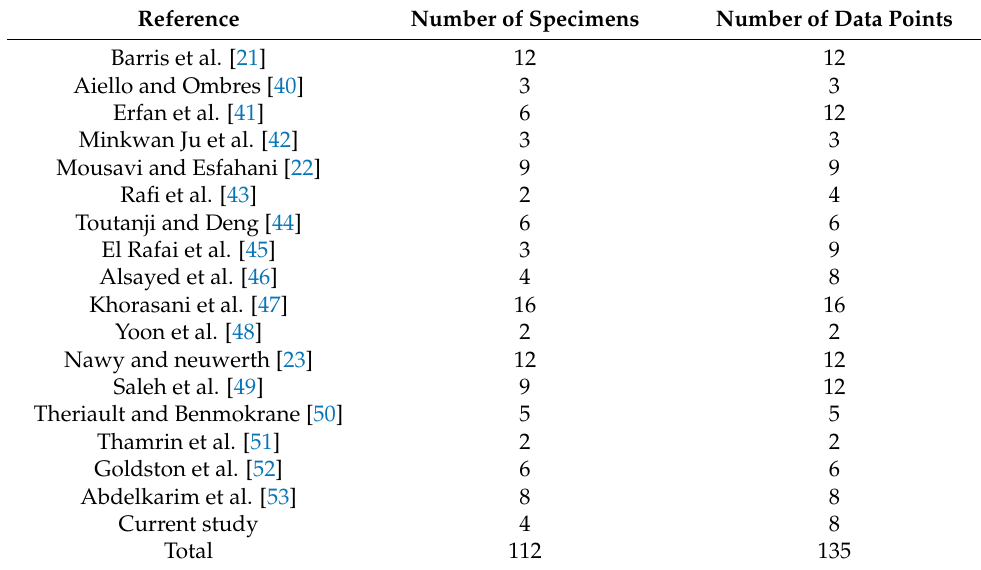
Table 1. Experimental studies of reinforced concrete members.